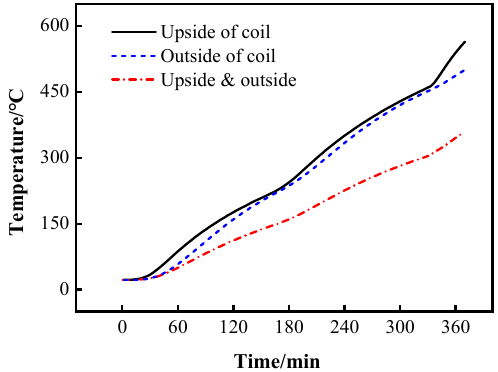
Figure 5. Induction coil temperature with di ff erent heat insulation material arrangement methods.